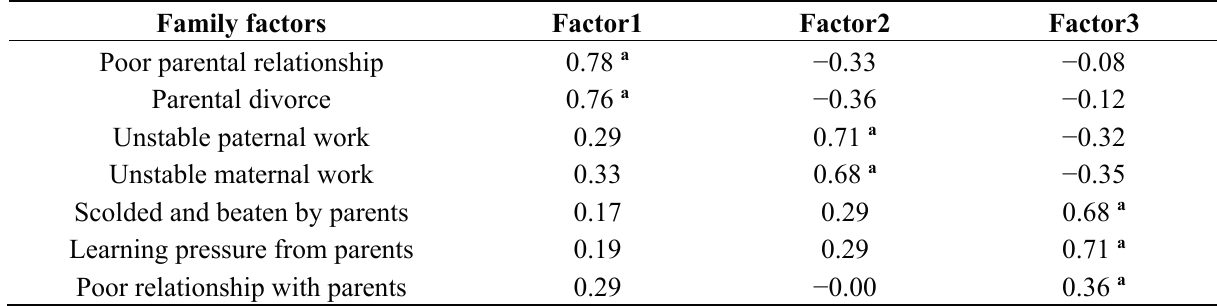
Table 2. Loadings on first rotated principal components for all university students. Family factors